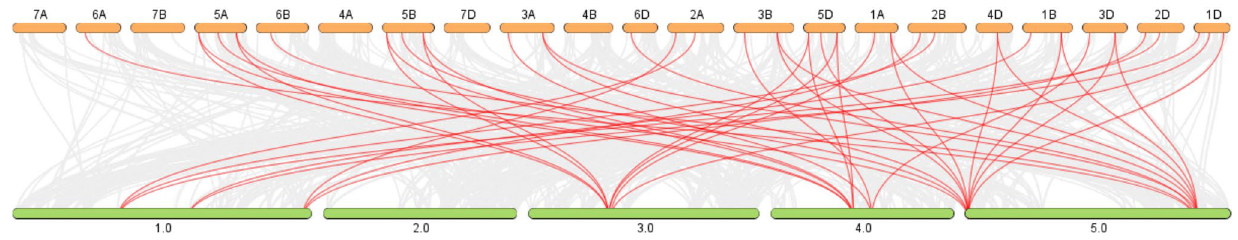
Figure 5. Synteny analysis of SnRK genes between Triticum aestivum (Orange colour) and Arabidopsis thaliana (green colour). Gray lines in the background indicate the collinear blocks within T. aestivum and A. thaliana , while the red lines highlight the syntenic SnRK gene